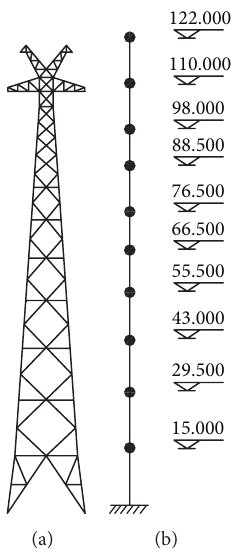
Figure 2: Analytical model of a transmission tower. (a) 3D FE mode. (b) 2D